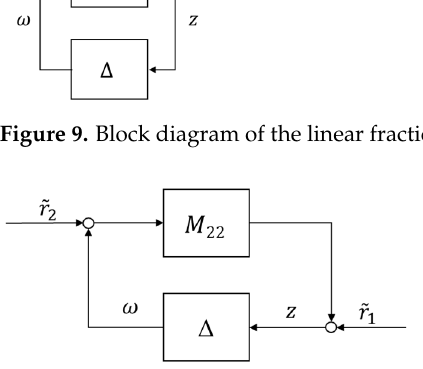
Figure 10. Block diagram of the small gain theorem.